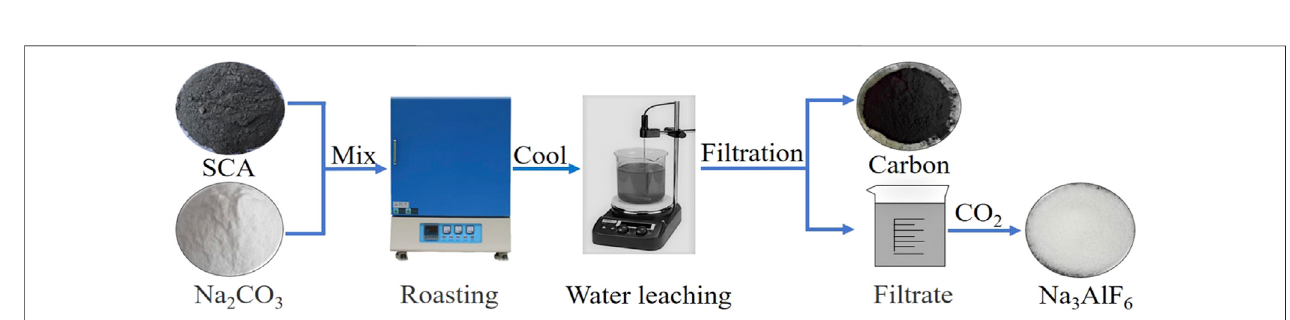
FIGURE 8 | SCA treatment via Na 2 CO 3 alkali fusion.